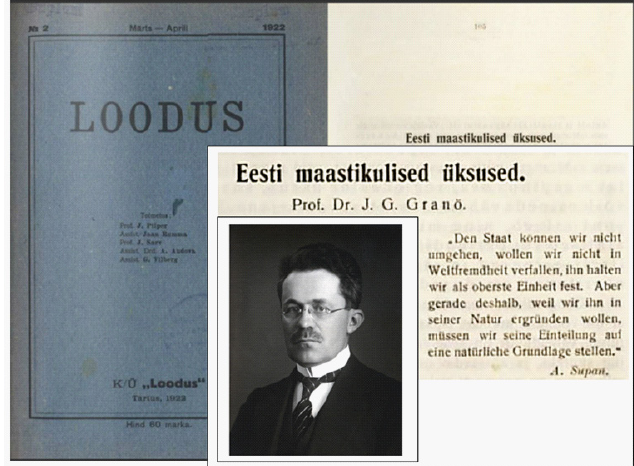
Figure 2: Left: J.G.Granö at the age of 42 (1924), and lower right corner: Cover and opening ciation of Loodus issue